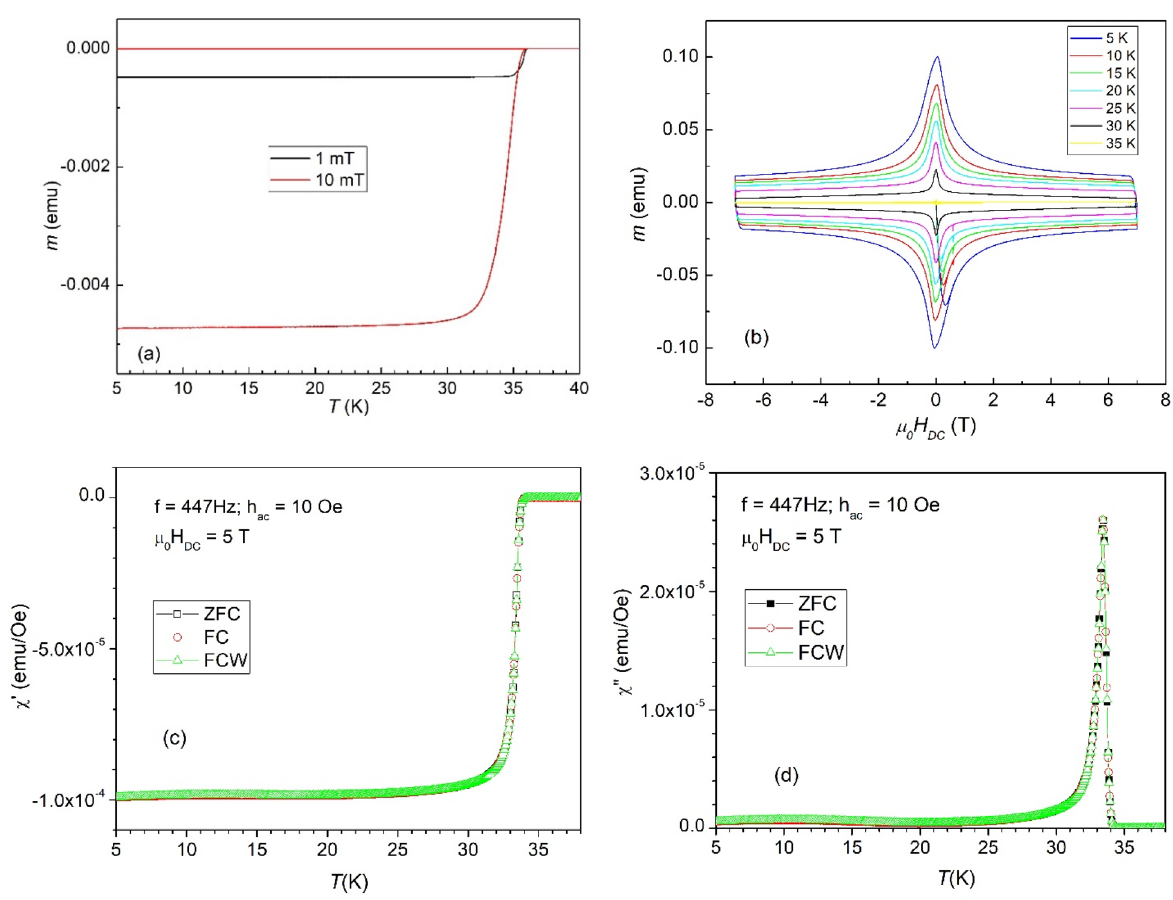
Figure 1. Temperature dependence of the magnetization in applied DC fields of 1 and 10 mT ( a ); magnetization hysteresis loops at several temperatures between 5 and 35 K, step 5 K ( b );